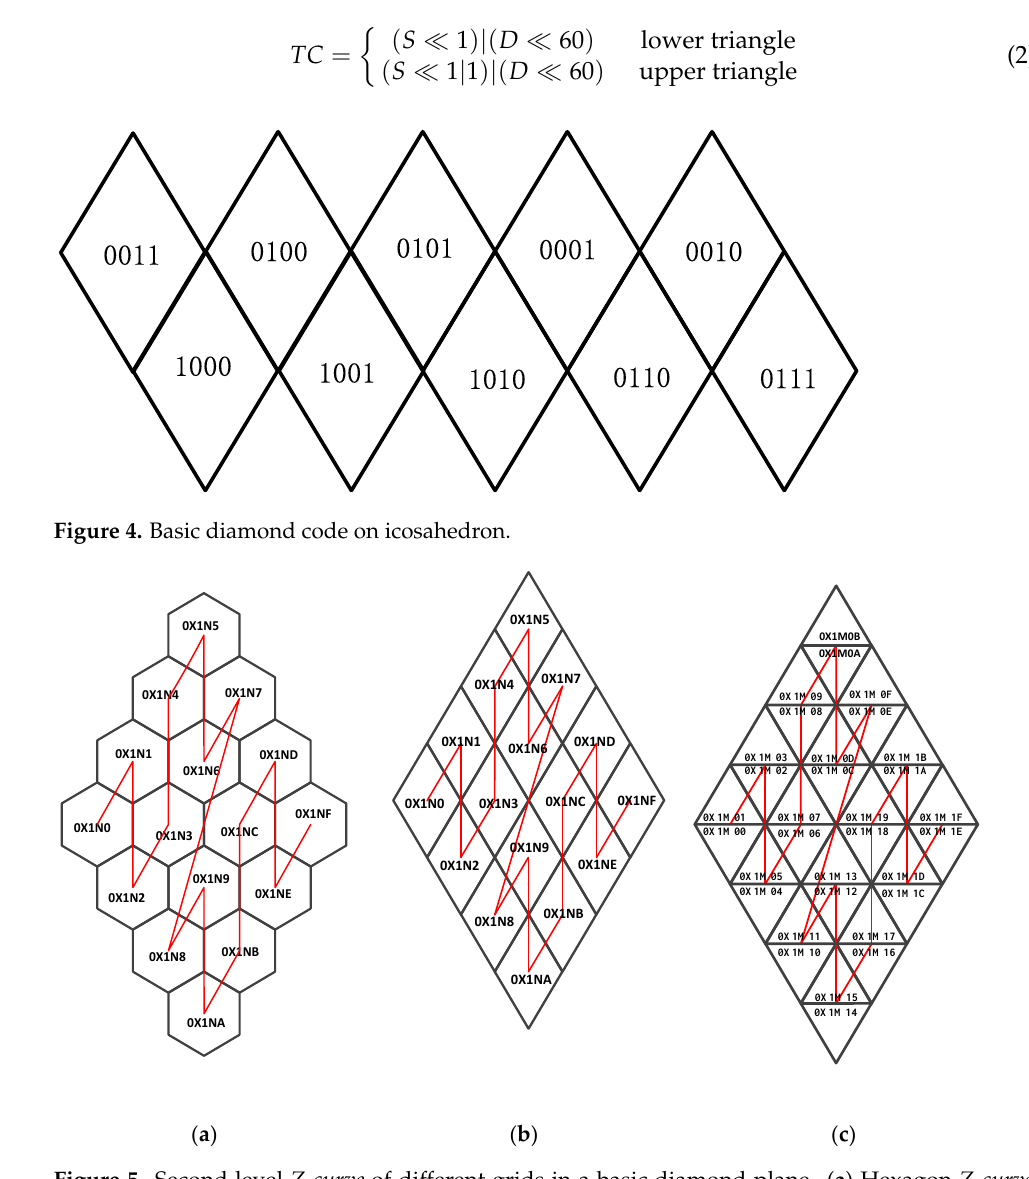
Figure 5. Second level Z-curve of different grids in a basic diamond plane. ( a ) Hexagon Z-curve ; ( b ) diamond Z-curve ; ( c ) triangle Z-curve .